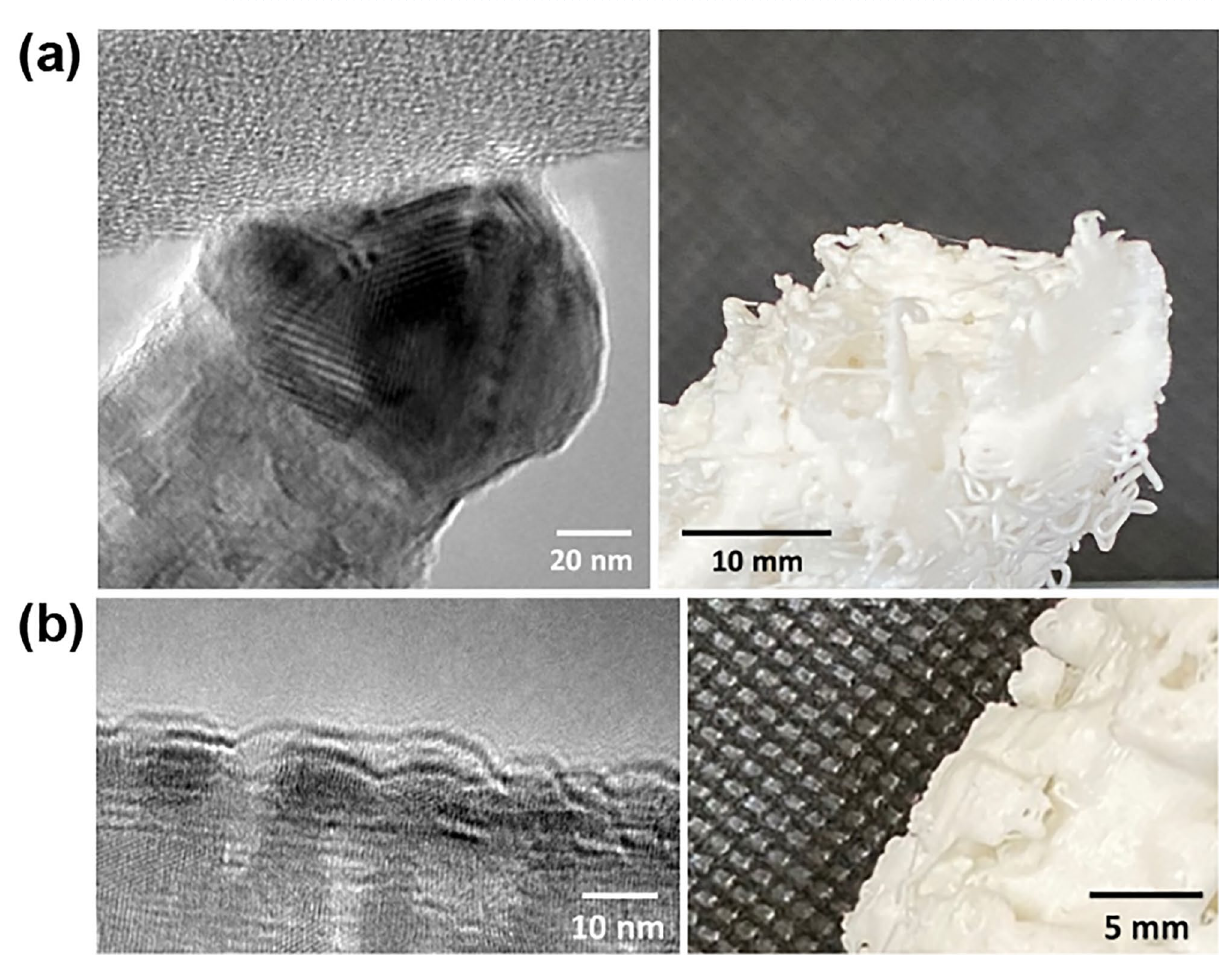
Figure 5. Magnified optical images (right) to confirm the visualization from the nanoscale measurement (left); ( a ) tip and ( b ) surface of the hierarchically-assembled ZnS